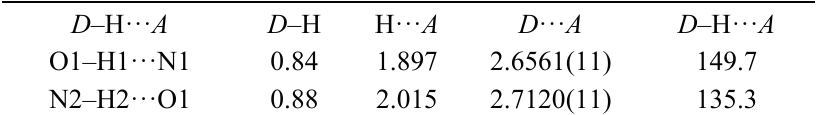
Figure 8. Crystal packing pattern of 9 along the a -axis with extended residues showing the hydrophobic contacts and the lack of intermolecular hydrogen bonding. Table 5. Hydrogen-bond geometry (Å, °) for 9 .